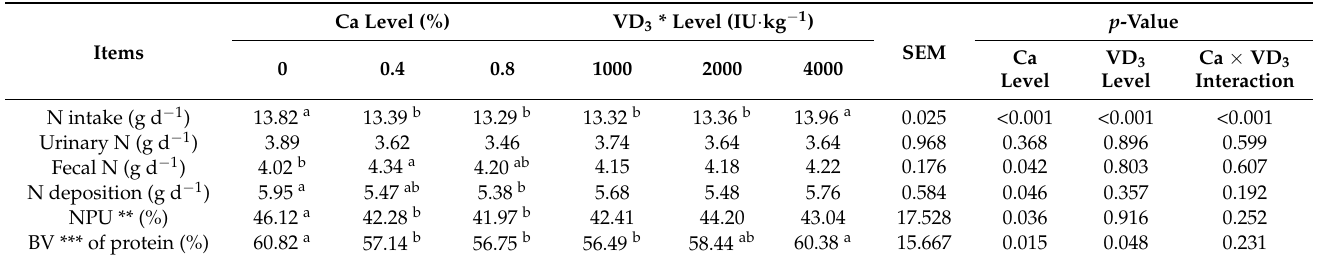
Table 4. The outcome of Ca and VD 3 diet supplementation on N metabolism in maturing and furring blue foxes.